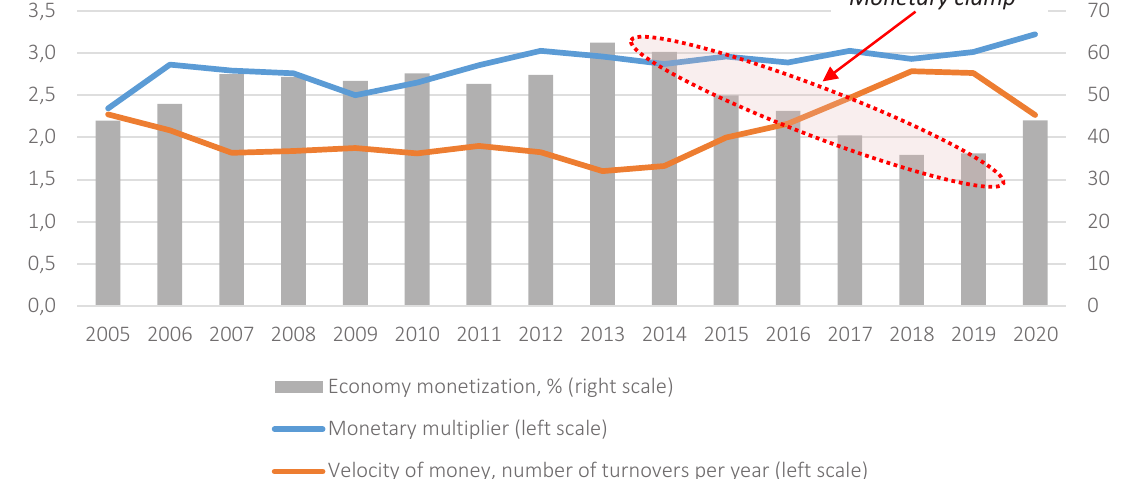
Figure 3. Monetary multiplier, speed of money turnover, and monetization ratio of the